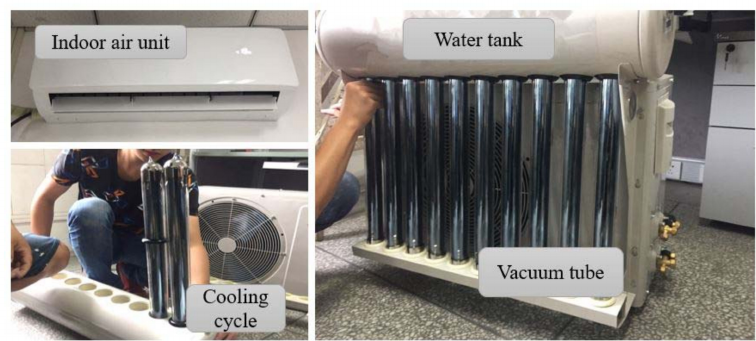
Figure 2. Solar-driven cooling cycle